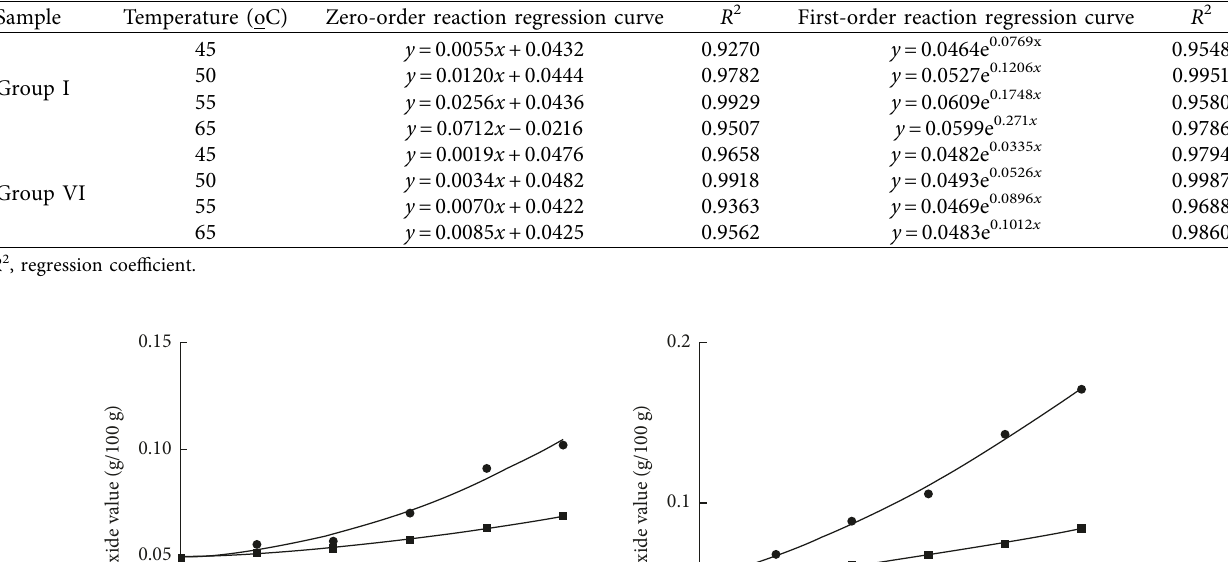
Table 2: The zero-order and first-order equations parameters of peanut oil with addition of Group I or Group VI antioxidant compounds at different temperatures.